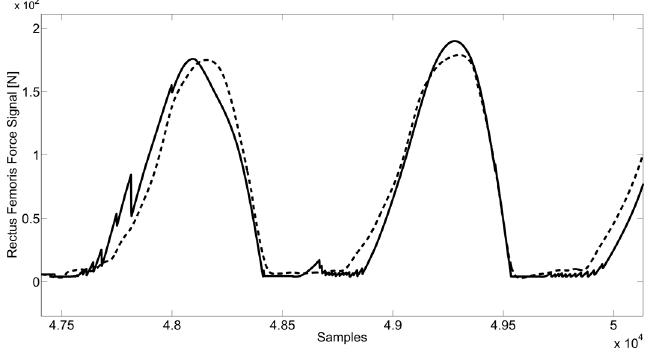
Figure 7. Muscle forces of rectus femoris obtained with the neural network (dashed) and with the deterministic algorithm optimization (solid). Sampling frequency 1000